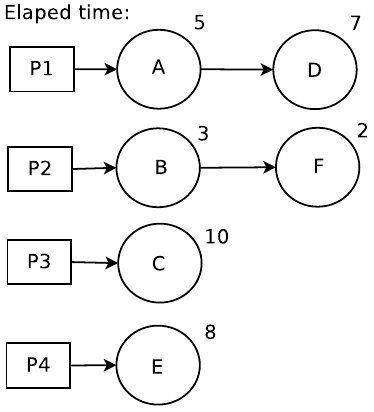
Fig. 1: An example of A GA individual.